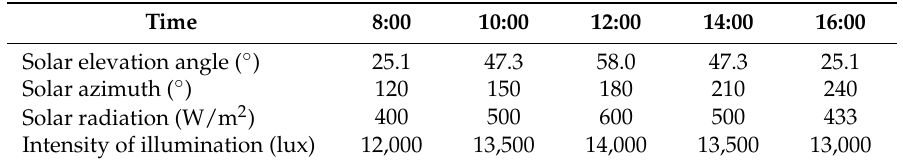
Table 2. The solar elevation angle, azimuth angle and illumination intensity at five times in Changzhou, China (32 ◦ N, 120 ◦ E).